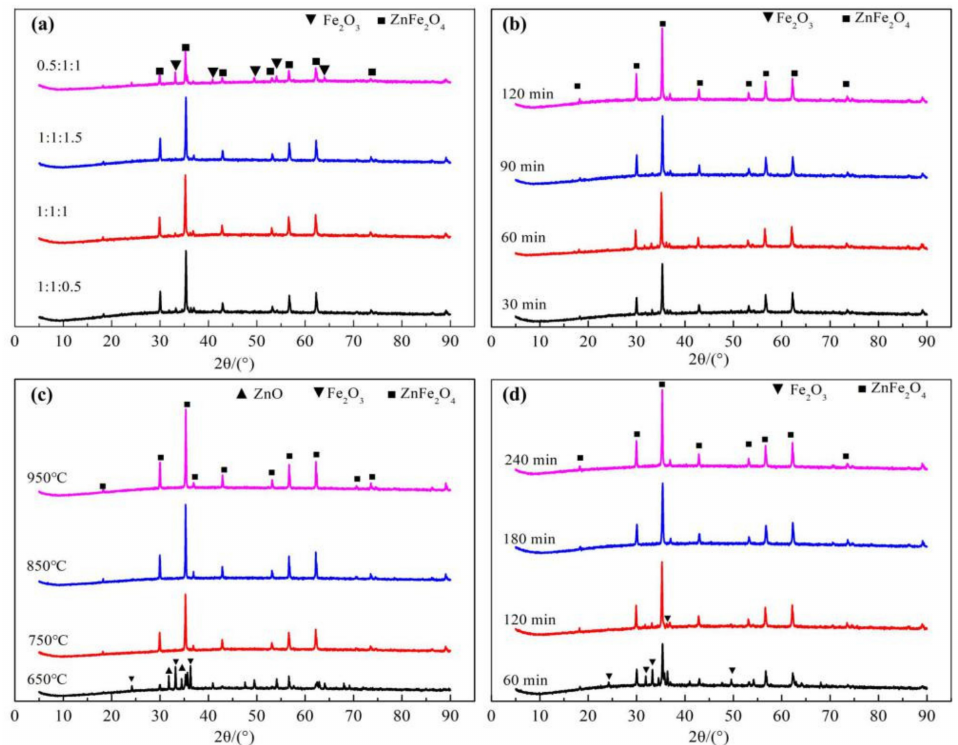
Figure 7. XRD patterns of roasted products under different conditions: ( a ) different ratio; ( b ) activation time; ( c ) roasting temperature; ( d ) roasting